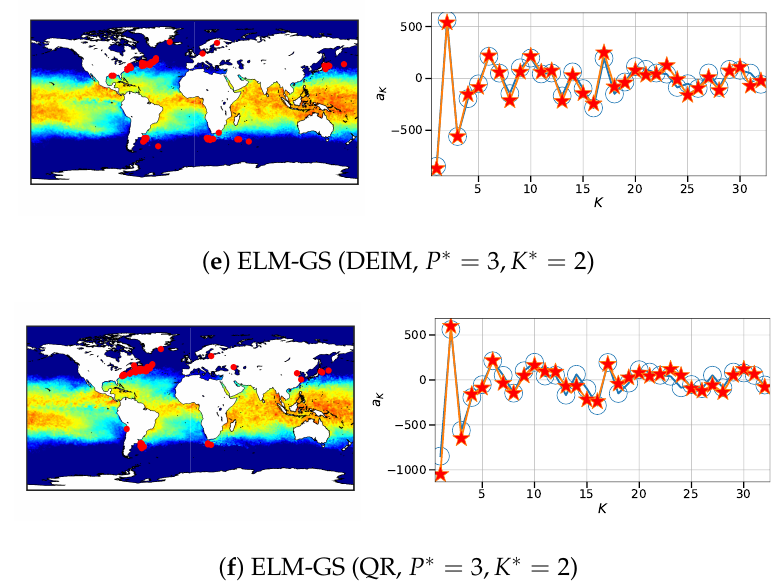
Figure 16. Left column: SR plot for sea surface temperature (SST) data with POD and ELM-GS basis using random, DEIM and QR sensor placement sampled marginally ( P ∗ = 3, K ∗ = 2). Right column: comparison of the estimated coefficients a using the entire data (blue circle) and the downsampled data (red star). Contour color: dark blue represents a temperature equal to or below 15 ◦ celsius and red represents a temperature equal or above 35 ◦ celsius.